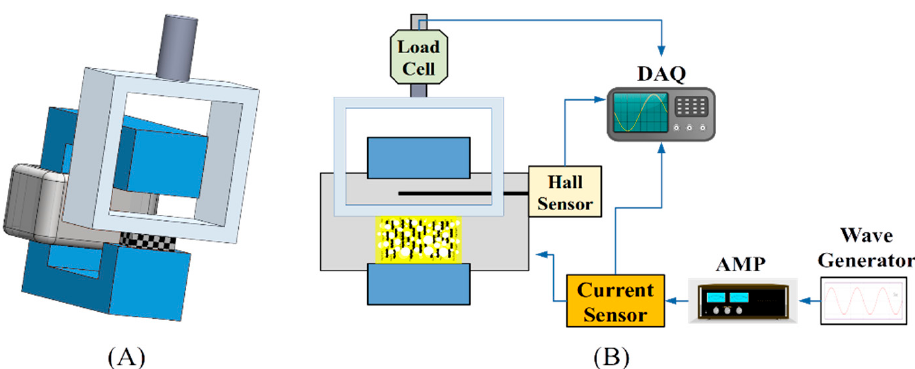
Figure A3. Experimental setup for the magnetoelastic characterization: ( A ) 3D sketch and ( B ) functional blocks.